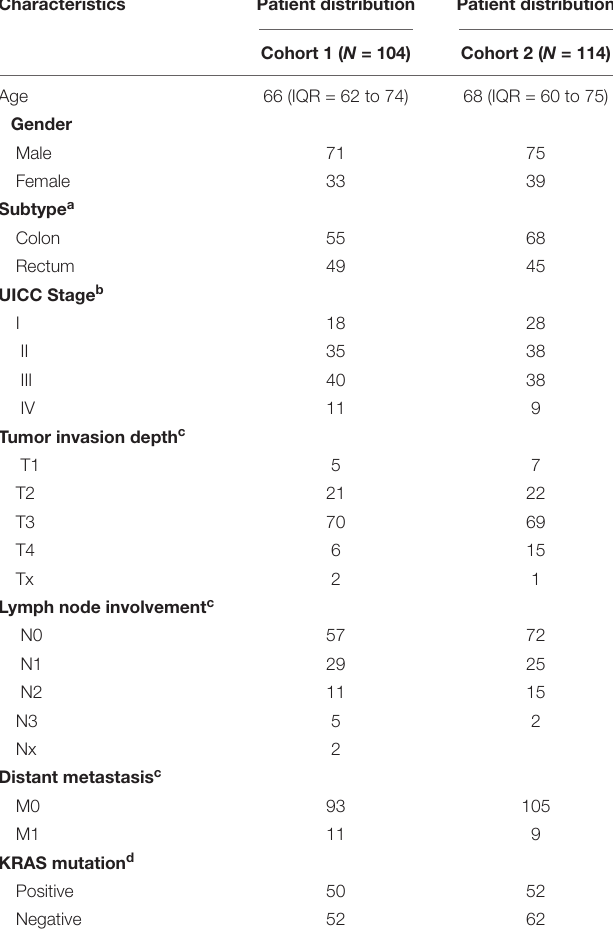
TABLE 1 | Characteristics of the CRC patients included in this